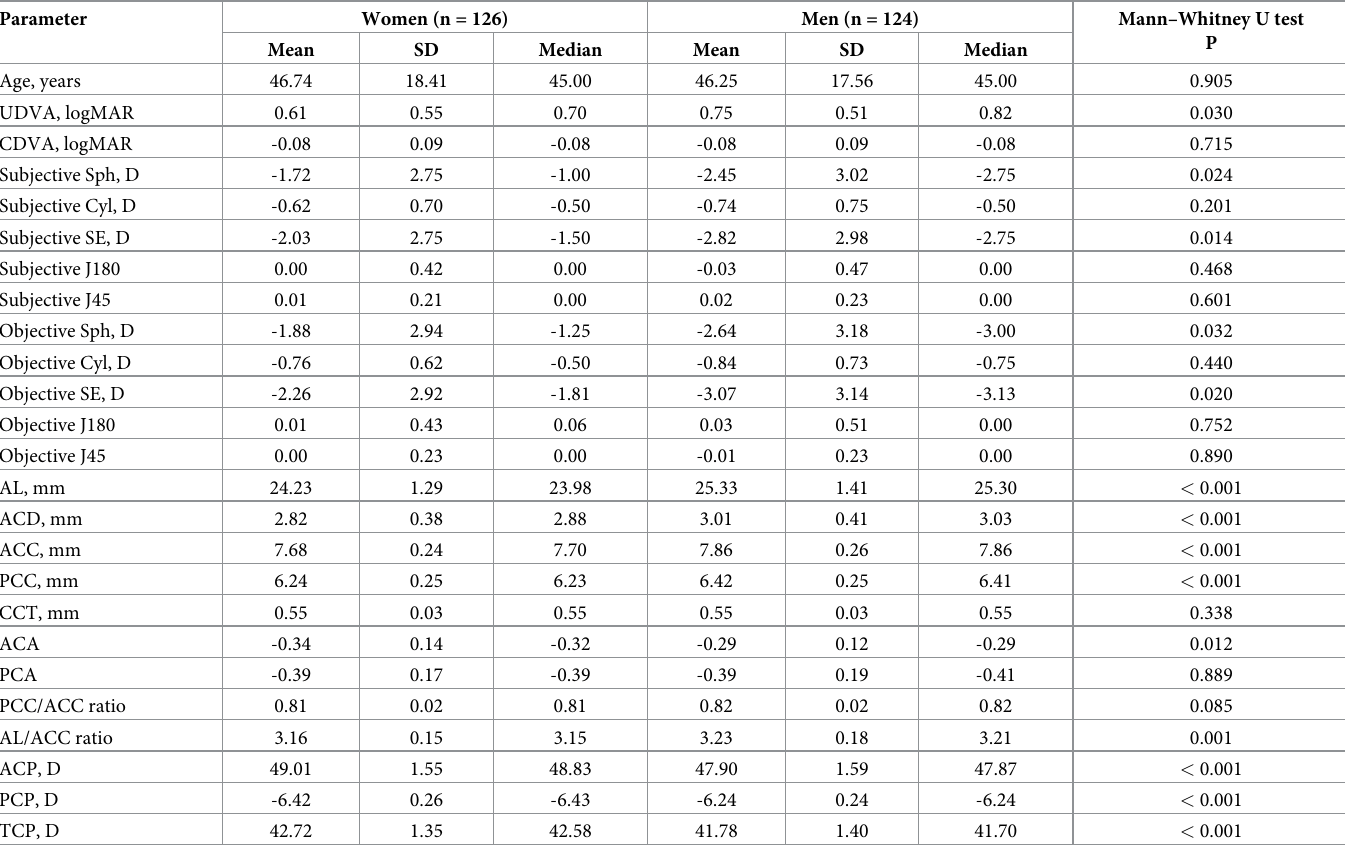
Table 4. Comparison of sex-based